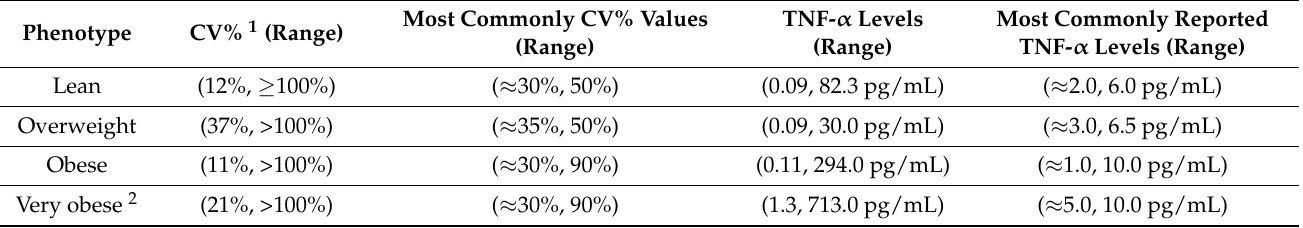
Table 1. Summary of the data on intragroup variability and levels of circulatory TNF- α in lean, overweight, obese, and very obese individuals as reported in the different human studies examined in this